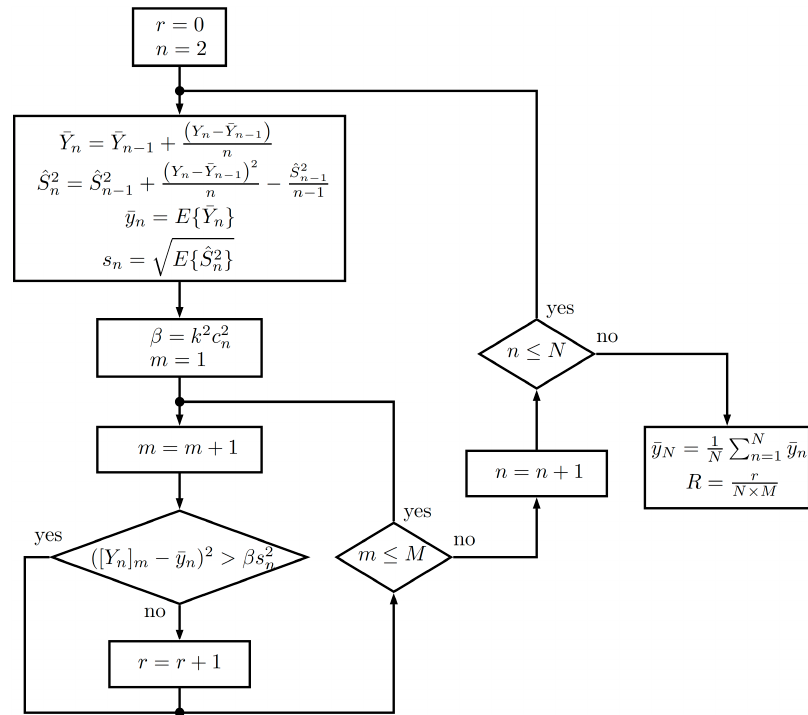
Figure 5. Reliability estimation algorithm.